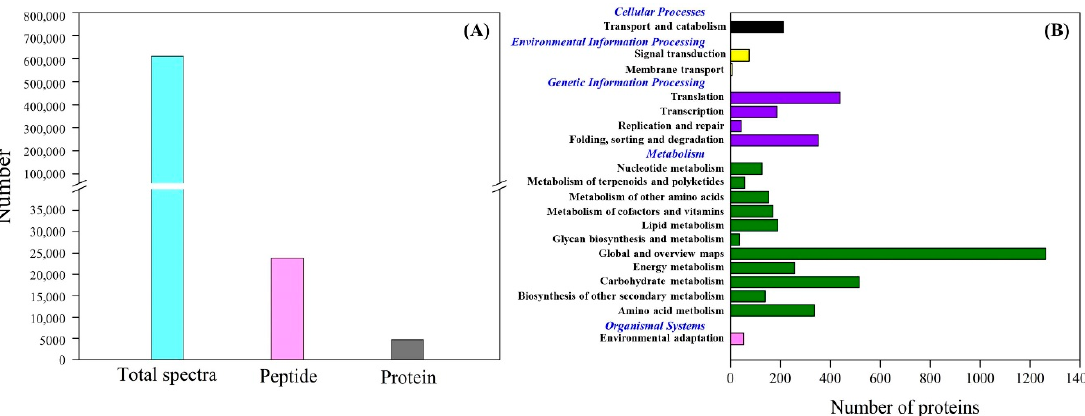
Figure 4. ( A ) Number of total spectra, total peptides, and total proteins, and ( B ) clusters of orthologous groups (COGs) analysis of total proteins in leaf of creeping bentgrass.